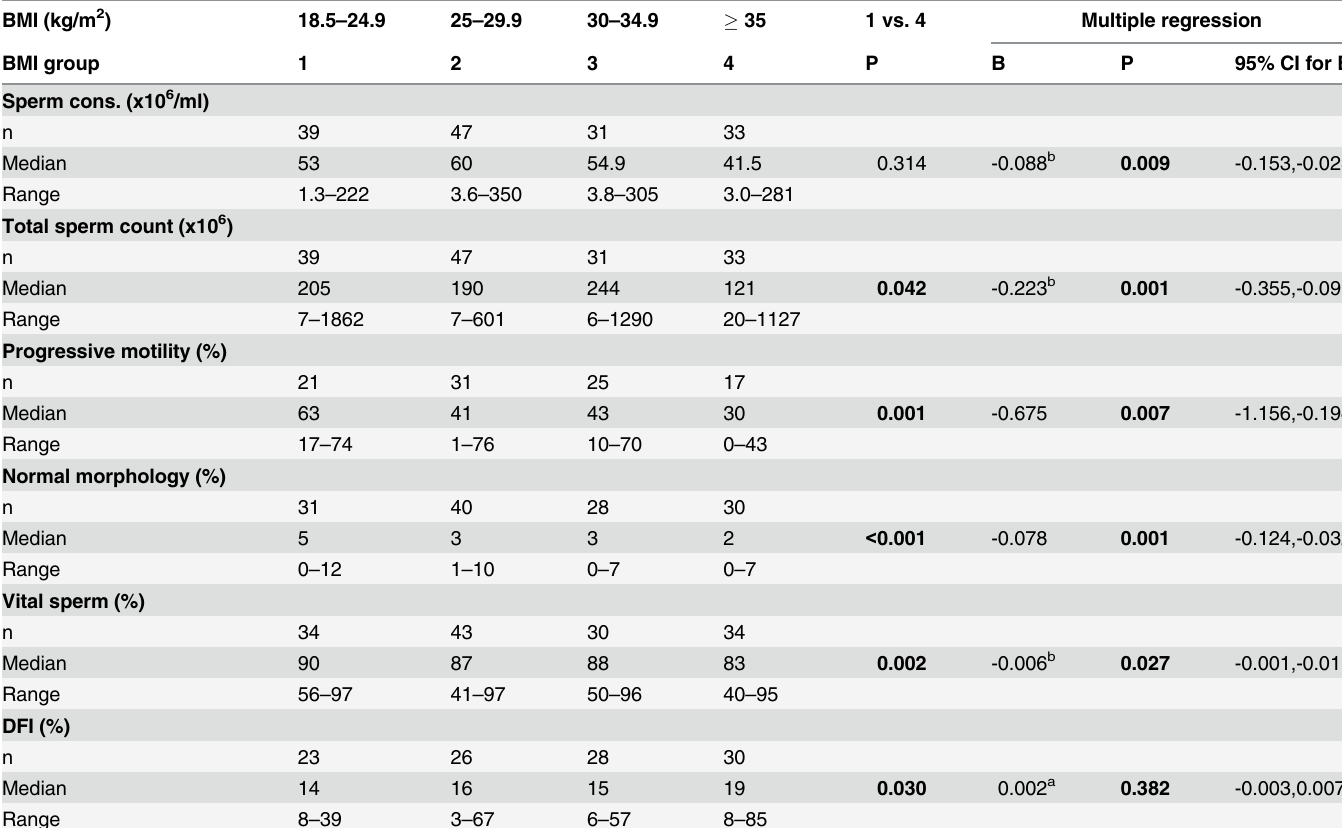
Table 2. Characteristics of semen parameters according to BMI groups, comparison between group 1 and group 4, and associations between BMI and semen parameters by multiple linear regression.